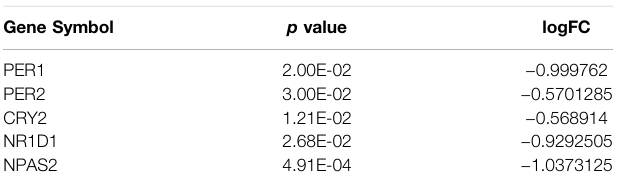
TABLE 2 | Clock genes obtained after crossover.